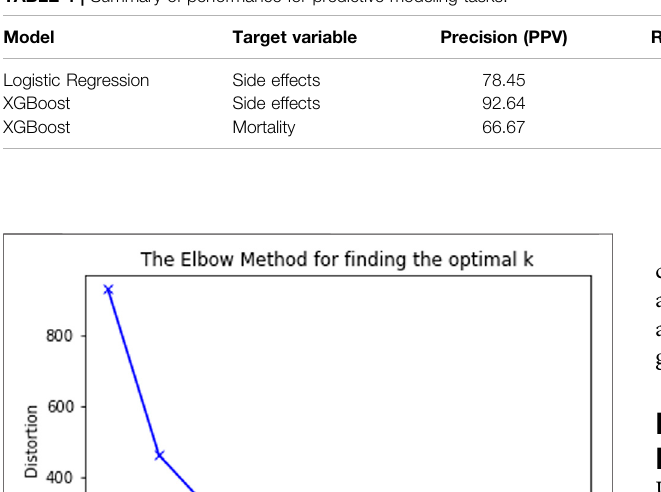
TABLE 4 | Summary of performance for predictive modeling tasks.